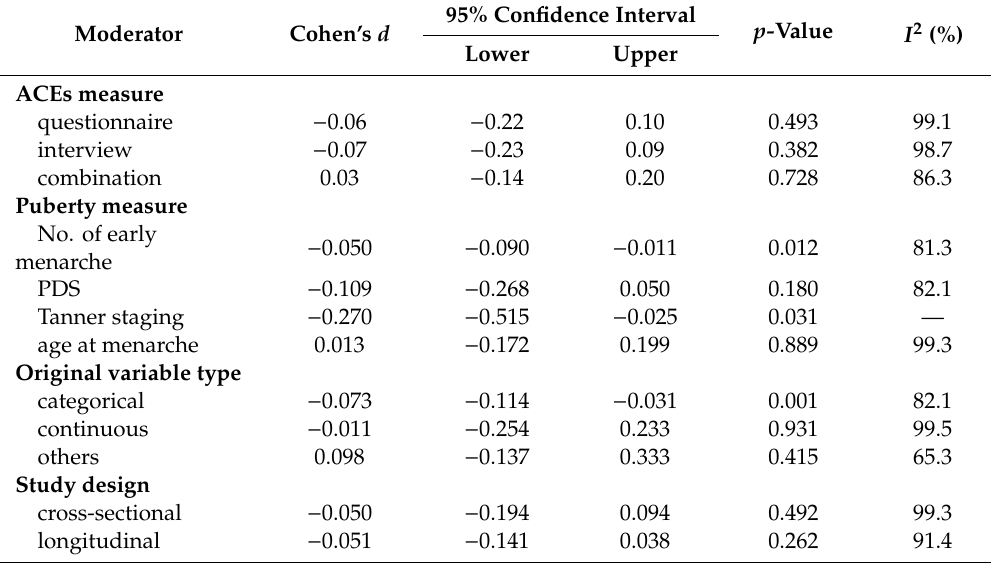
Table 3. Subgroup analyses of Associations between ACEs and Early Pubertal